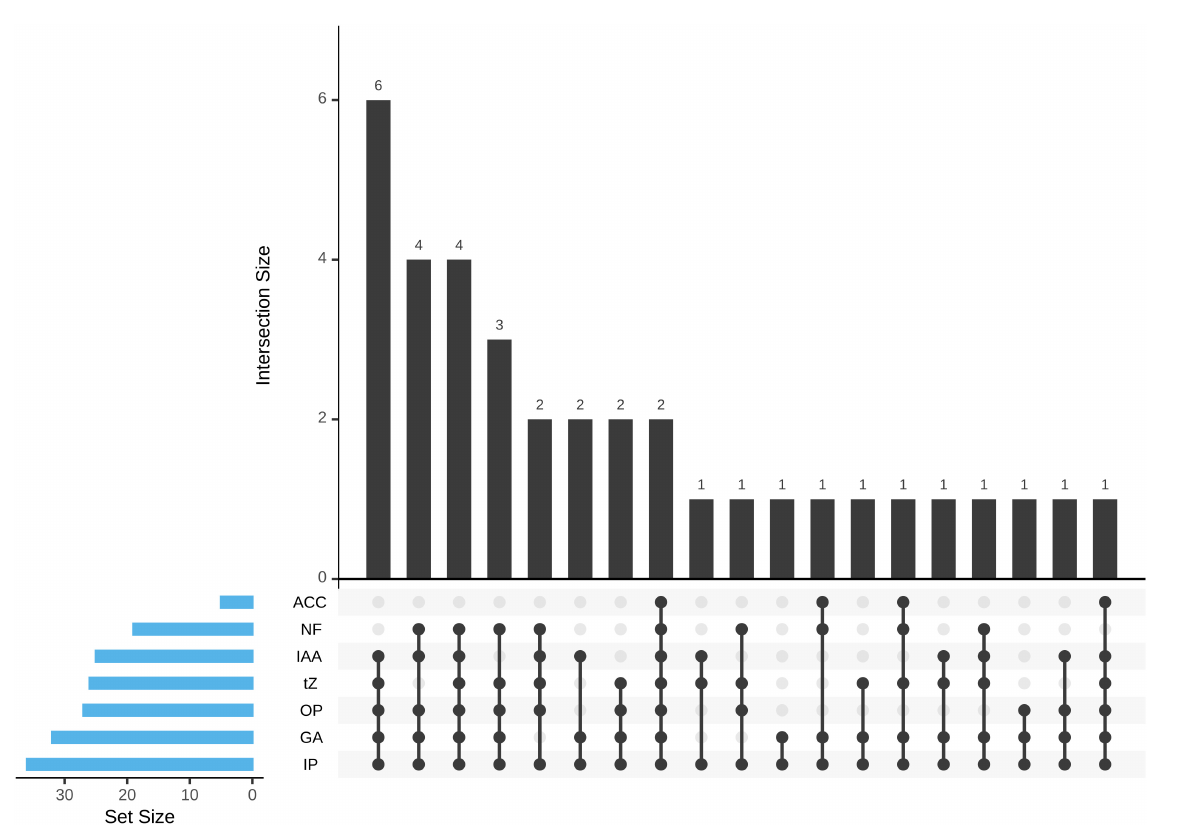
FIGURE3 The upset plot representation of the 36 Pseudomonas sp. strains was allocated to seven different plant growth-promoting (PGP) traits. ACC, ACC deaminase activity; NF, nitrogen fixation; IAA, IAA production; tZ, t-Z production; OP, organic phosphate solubilization; GA, GA 3 production; IP, inorganic phosphate